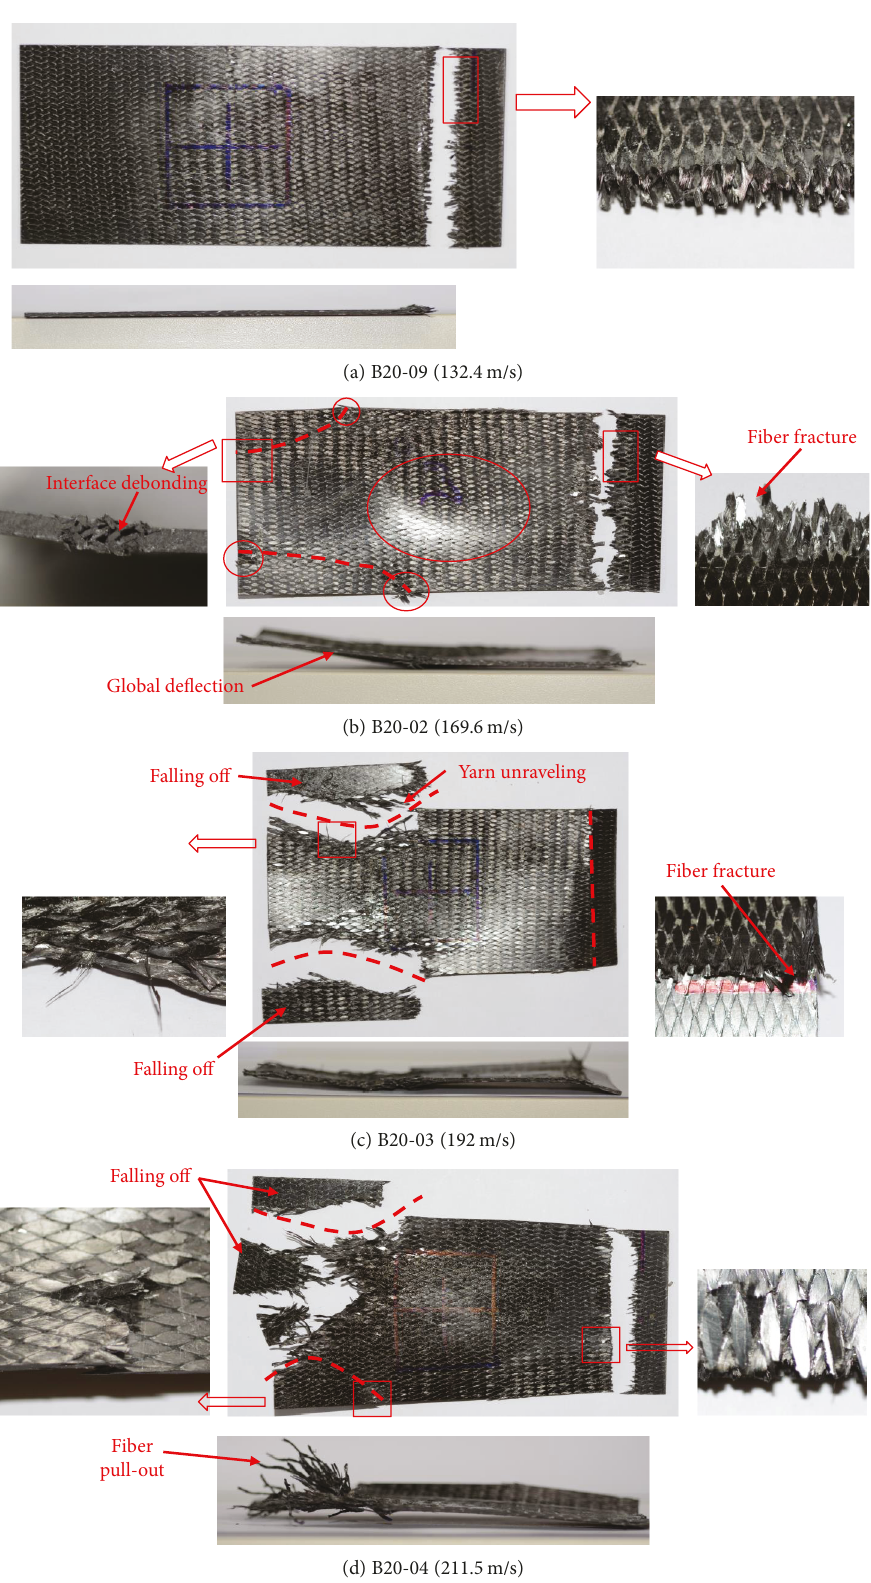
Figure 6: Deformation and damage morphology of 20 ° braiding composite target at di ff erent impact